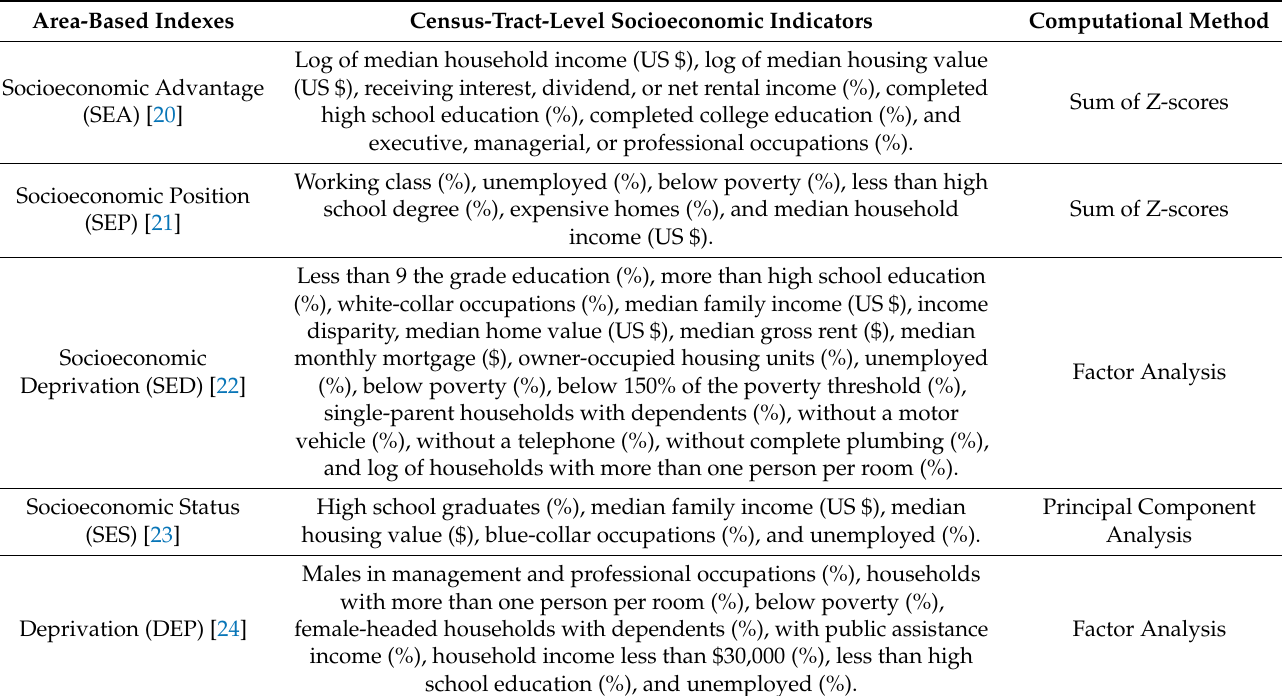
Table 1. Description of five area-based indexes developed in the United